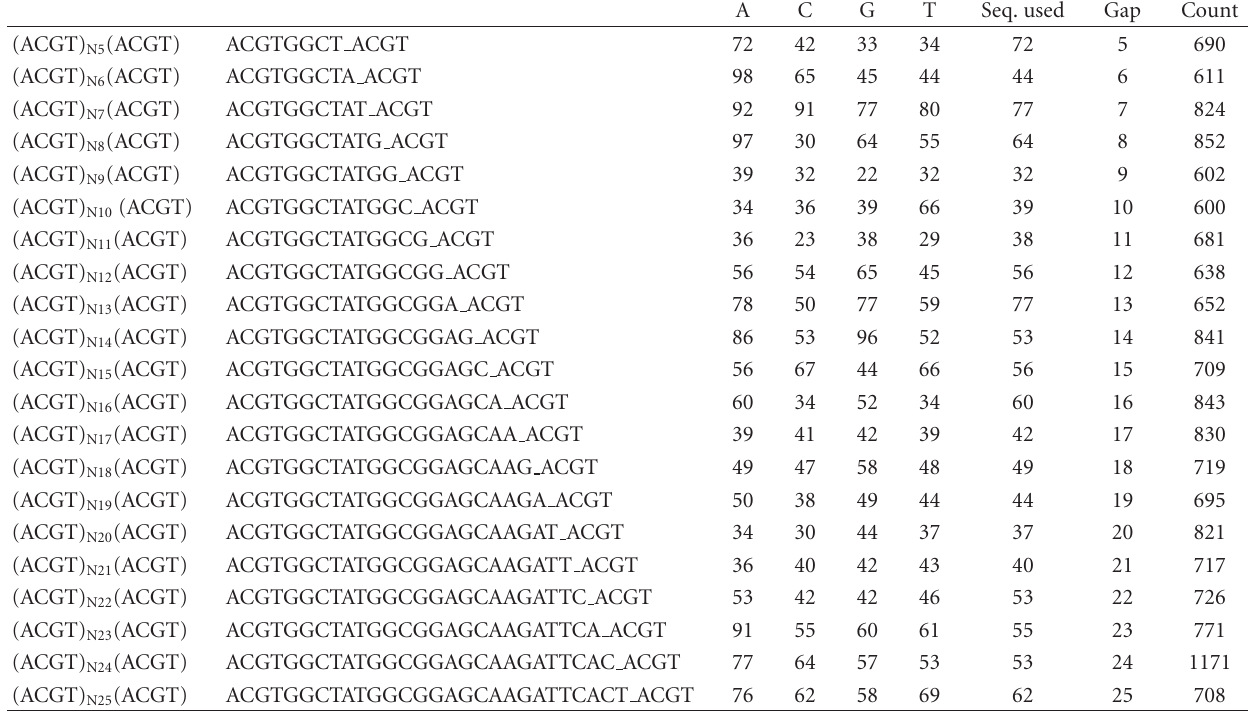
Table 2: Frequency of occurrence of nitrogenous bases when spacer sequence length between two ACGT palindromes is gradually increased from 5 to 25 nucleotides.